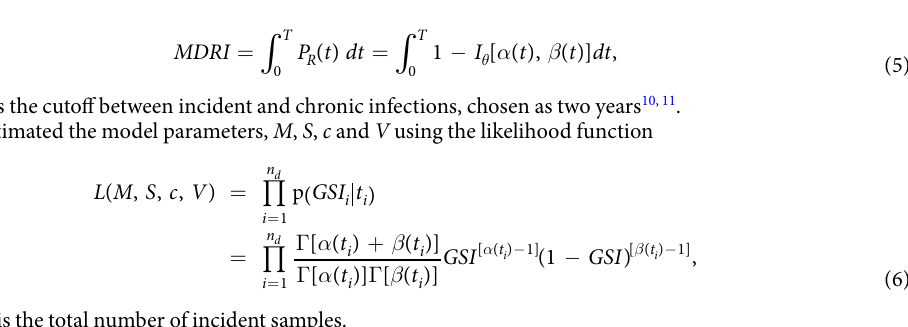
where n d is the total number of incident samples. The fitted biomarker dynamics clearly traced the average GSI dynamics measured from 438 incident speci- mens (Fig. 3A). Importantly, the model Beta distribution also reflects the profile of GSI variability across individ- uals over time. The GSI probability density function peaked close to a GSI of 1 in early infection and at a GSI of 0 around 2 years post infection (Fig. 3B). Around 1 year post infection the incident subjects’ GSIs were bimodal,